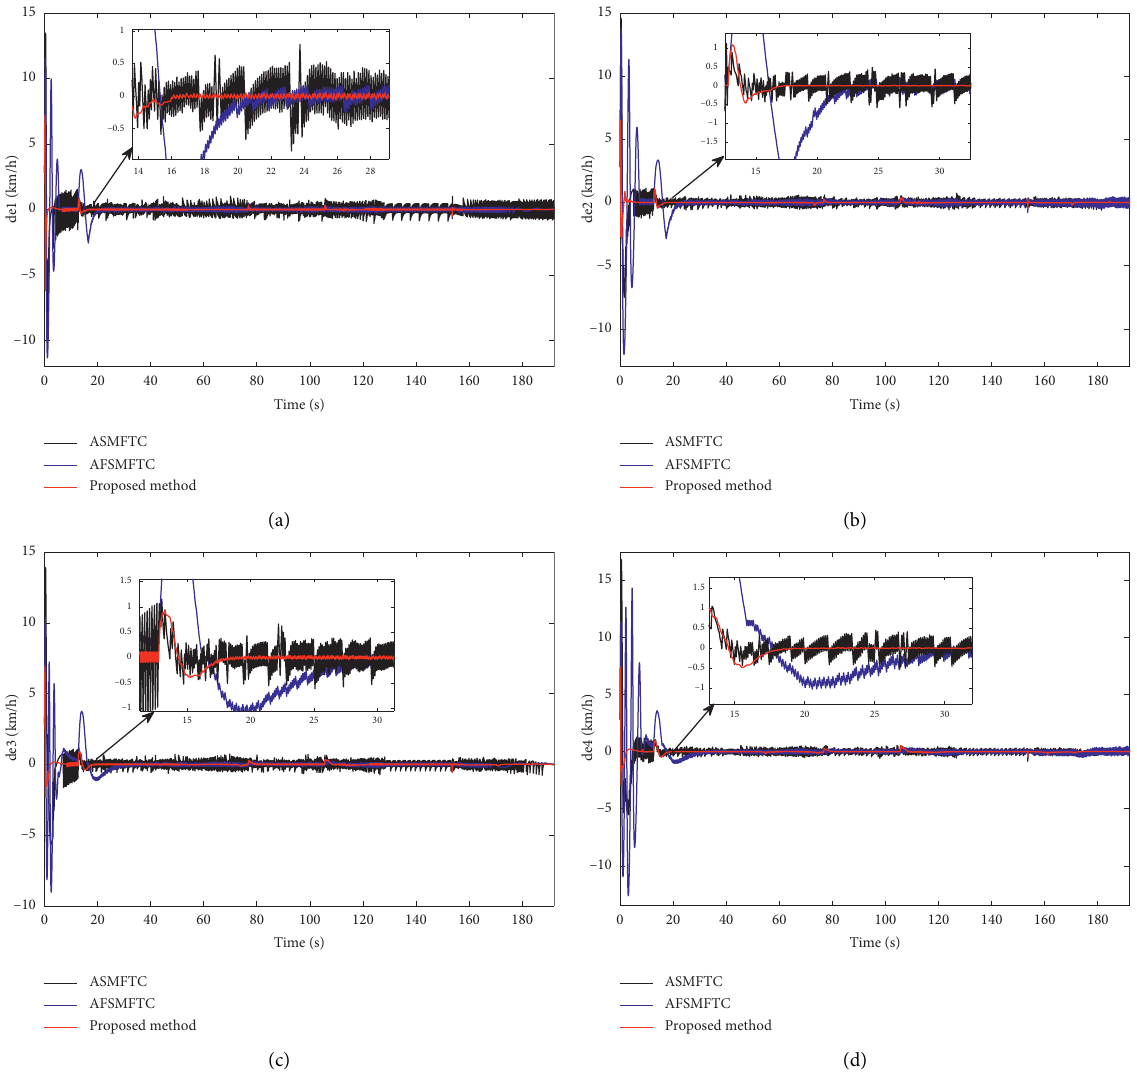
Figure 5: The speed tracking errors of MHSTs using different fault-tolerant control methods. (a) The speed tracking error of train 1. (b) The speed tracking error of train 2. (c) The speed tracking error of train 3. (d) The speed tracking error of train